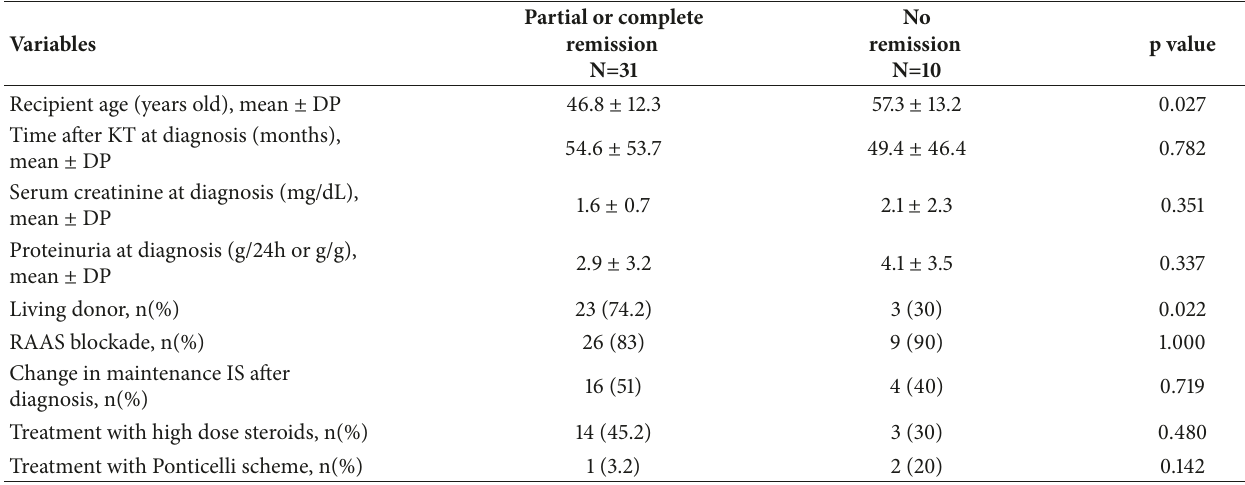
Table 4: Risk factors for posttransplant MN